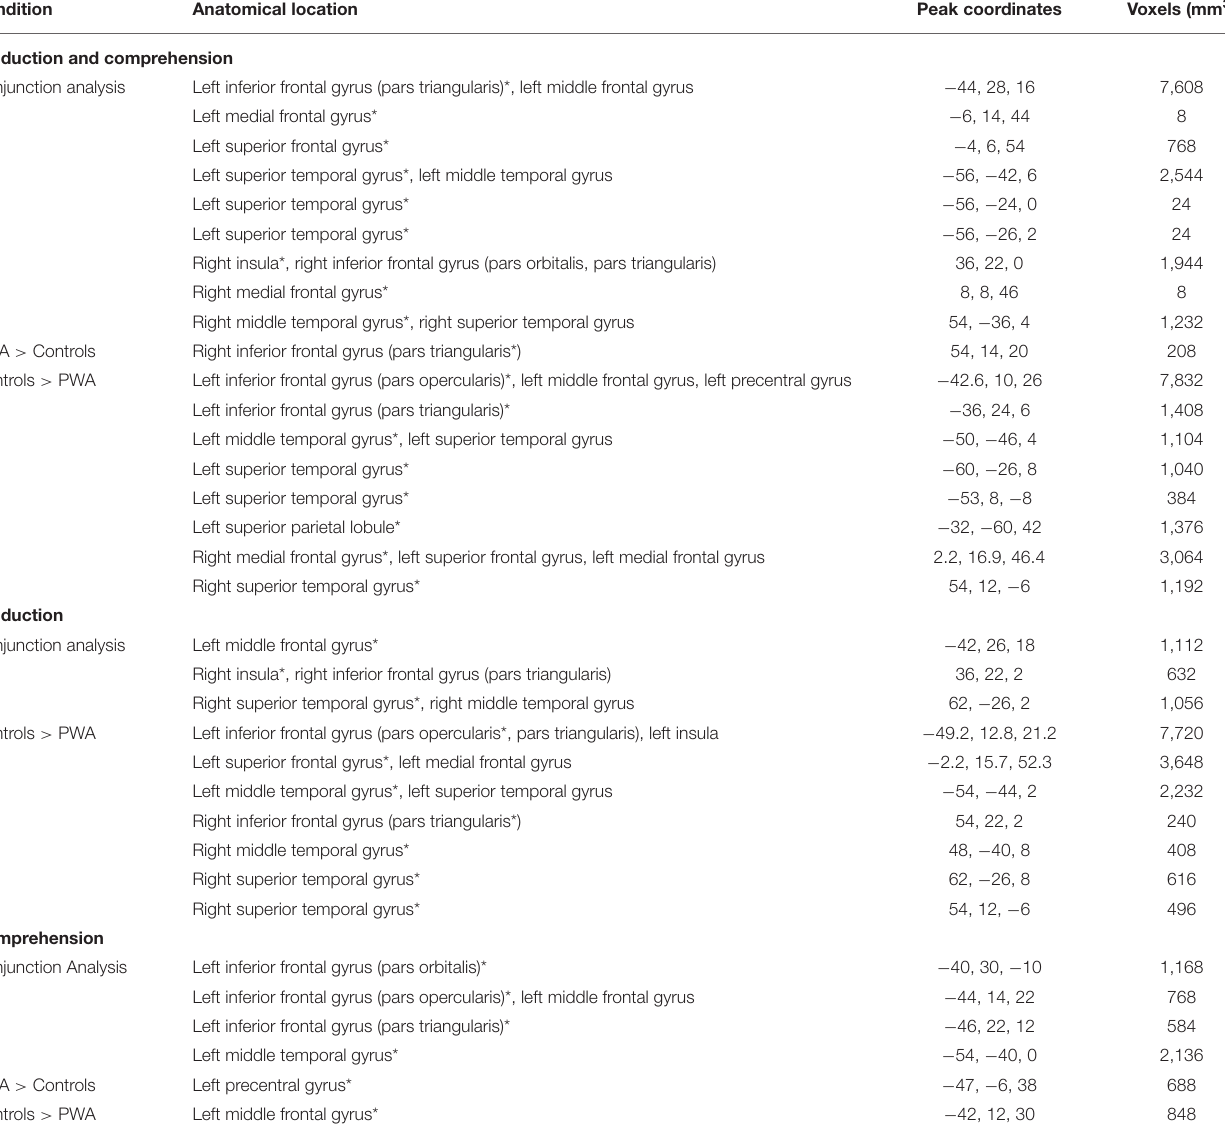
TABLE 3 | Anatomical locations of peak coordinates and cluster size for each contrast ALE comparing PWA and controls. Condition Anatomical location Peak coordinates Voxels (mm 3